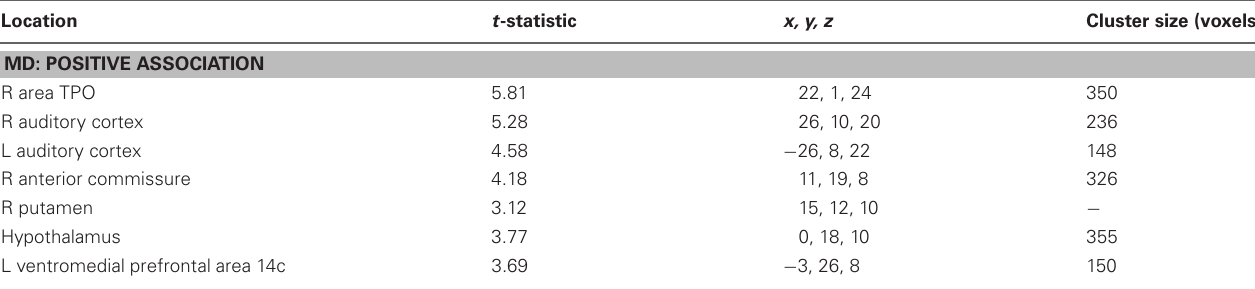
Table A1 | Regions where total error rate was significantly correlated with mean diffusivity in voxel-wise analyses. Location t -statistic x, y,